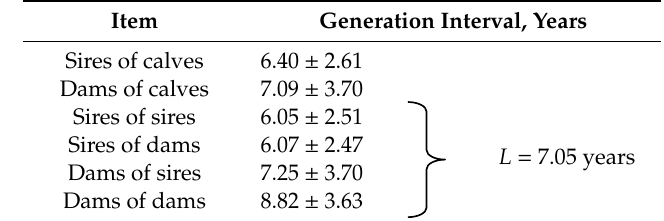
Table 1. Mean generation intervals ± standard deviation (SD) for all calves born and for the 4 paths of selection.